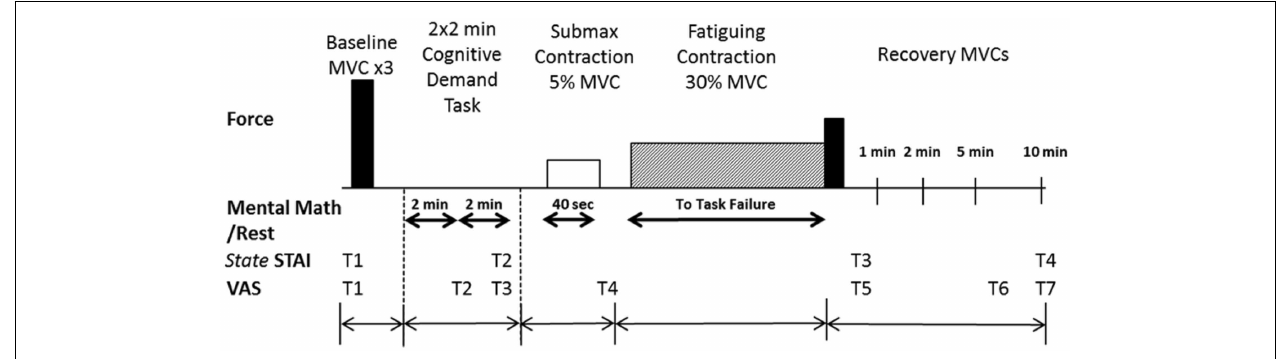
contraction (30% MVC), symbolized by the hatched rectangle, was performed until task failure by each participant.The bottom panels indicate when the State-Trait Anxiety Inventory (STAI; four times) was performed and theVisual Analog Scale (VAS) for anxiety and stress were recorded (at seven time points,T1–T7).The schematic is not to scale for time or